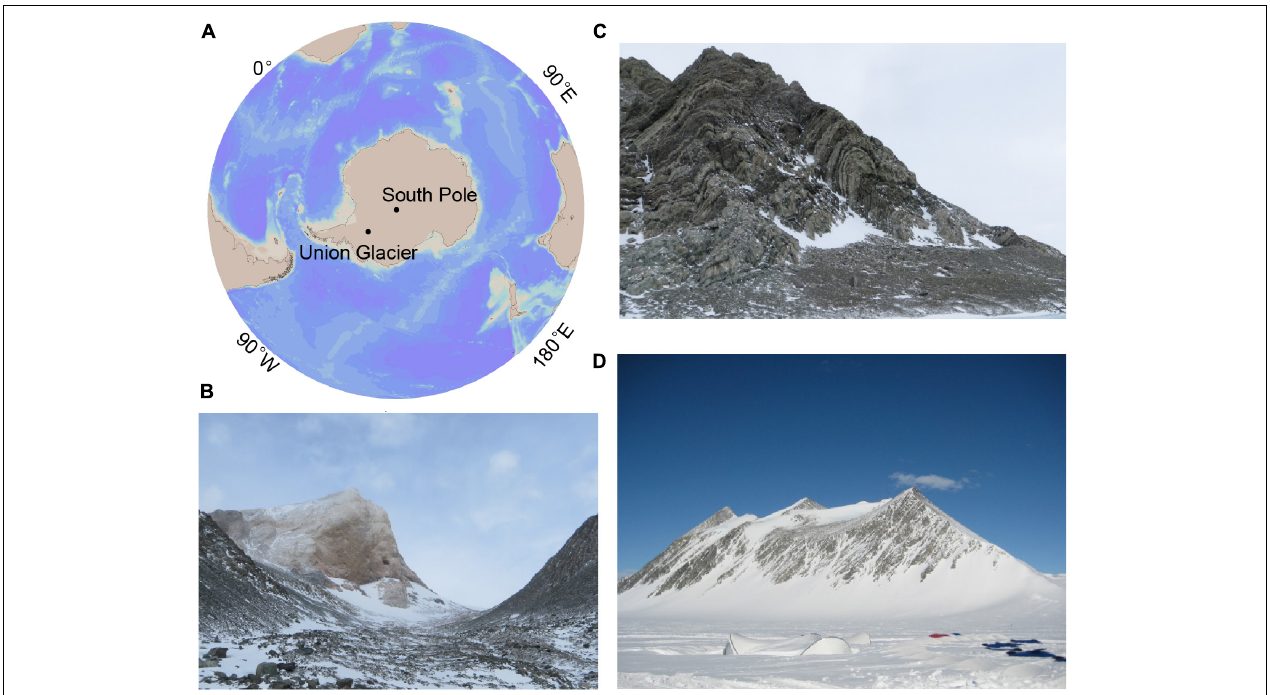
FIGURE 1 | Union Glacier site and photos of sampled glacier mountains. (A) Map of Antarctica illustrating the location of Union Glacier. (B) Photograph of the Elephant Head. (C) Photograph of the Charles Peak. (D) Photograph of the Rossman Cove.